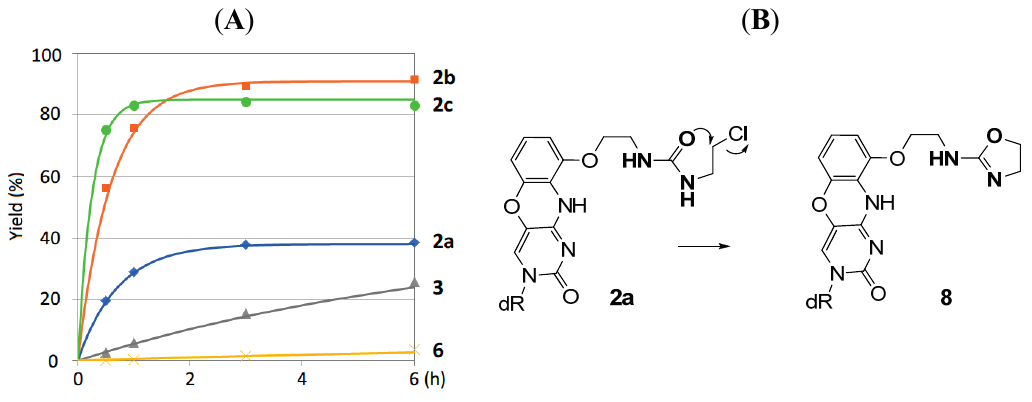
Figure 2. Reaction of 8-thioG-grasp with tri-Ac-8-thioG monitored by HPLC. dR and R represent 3 ′ ,5 ′ -diOTBS-2 ′ -deoxyribosyl and triacetyl ribosyl groups, respectively. The reaction was performed using 0.4 mM each of 2b and 8-thioG in the presence of 20 mM Et 3 N in CH 3 CN at 50 °C. HPLC conditions: column: Xbridge C8 3.5 μ m, 3.0 mm × 100 mm; solvents: ( A ) 0.1 M TEAA buffer at pH 7.0 and ( B ) CH 3 CN, A/B = 20:80; flow rate: 0.5 mL/min; monitored by UV at 254 nm.